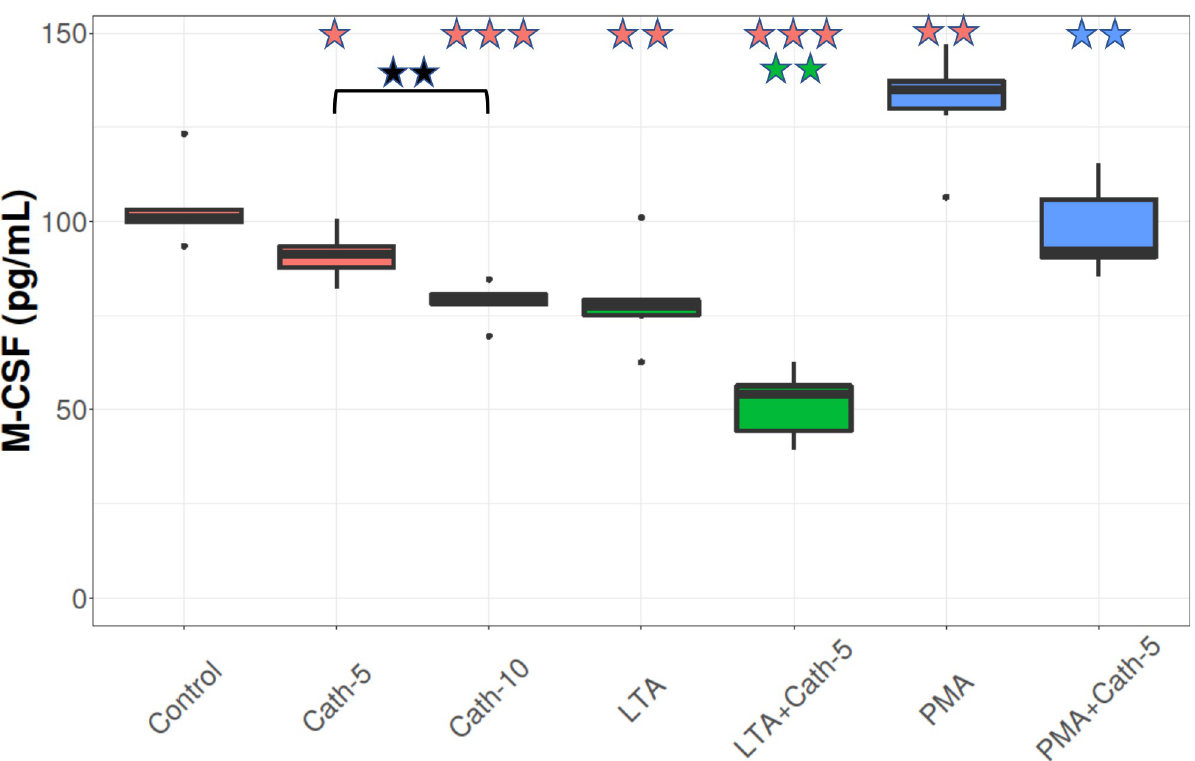
Fig 6. M-CSF concentration. Boxplots showing the macrophage colony stimulating factor (M-CSF) concentration for hepatocyte—non-parenchymal cell co-cultures treated with chicken cathelicidin-2 (Cath), lipoteichoic acid (LTA), or phorbol myristate acetate (PMA) only, or the combination of Cath and LTA or PMA (n = 6/group Results are displayed as pg/mL. Cath-5 = 5 nmol/mL Cath, Cath-10 = 10 nmol/mL Cath, LTA = 50 μ g/mL Staphylococcus aureus LTA, PMA = 1000 ng/mL PMA. The Control refers to absolute control cells that received none of the treatments. Red asterisks over the boxes refer to significant differences compared to control cells, green asterisks to the group treated only with LTA, blue asterisks to the group treated only with PMA, and black asterisks between the two concentrations of Cath. � p < 0.05, �� p < 0.01, ��� p < 0.001.